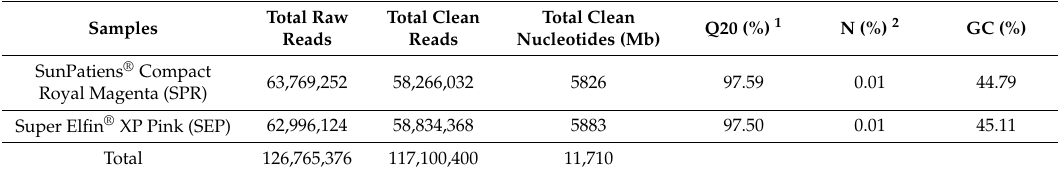
Table 1. Summary of HiSeq sequencing data for two impatiens leaf transcriptomes.